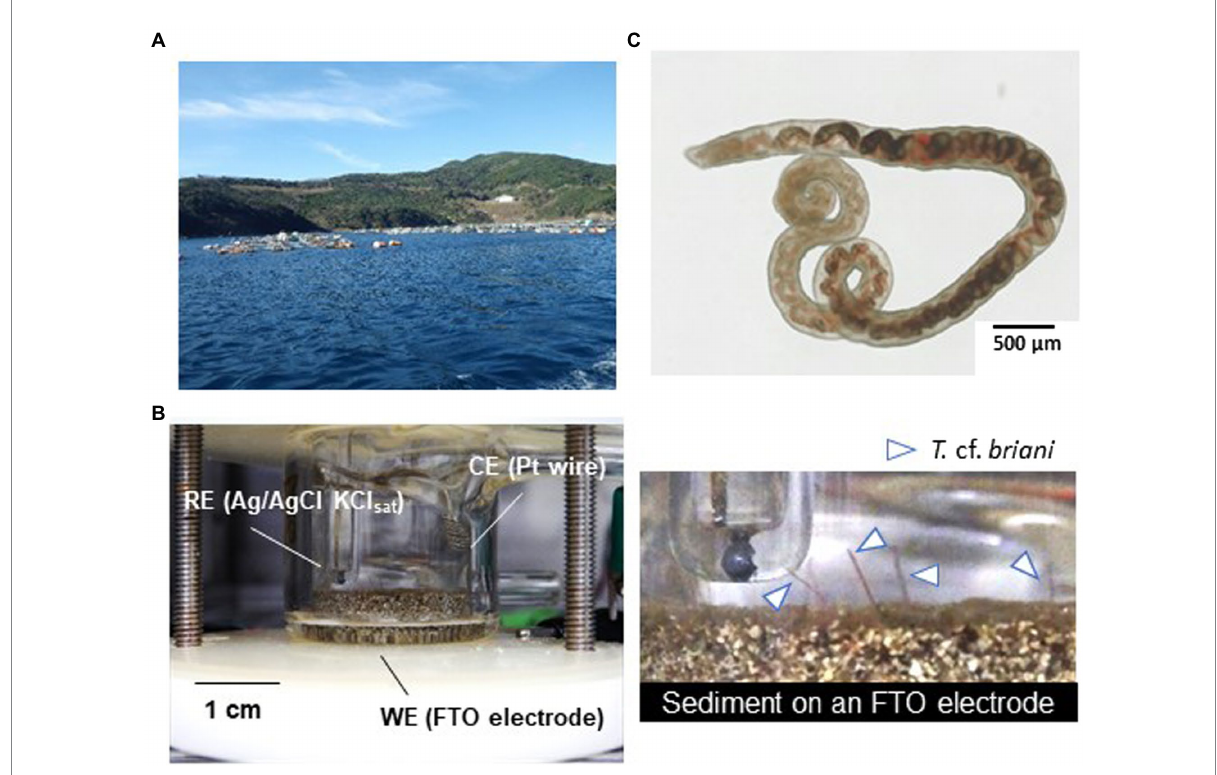
FIGURE 1 (A) Photograph of the fish farm where the sediments used in this study were collected. (B) Photographs of the model benthic ecosystem constructed in an electrochemical reactor. RE, WE, and CE denote the reference, working, and counter electrodes, respectively. The objects indicated by the arrows are the tails of oligochaetes protruding from the sediment mounted on the surface of a fluorine-doped tin oxide (FTO)- coated glass electrode. (C) Light microscope image of the specimen of the marine oligochaete Thalassodrilides cf. briani , which was located in sediment samples collected directly beneath the aquaculture